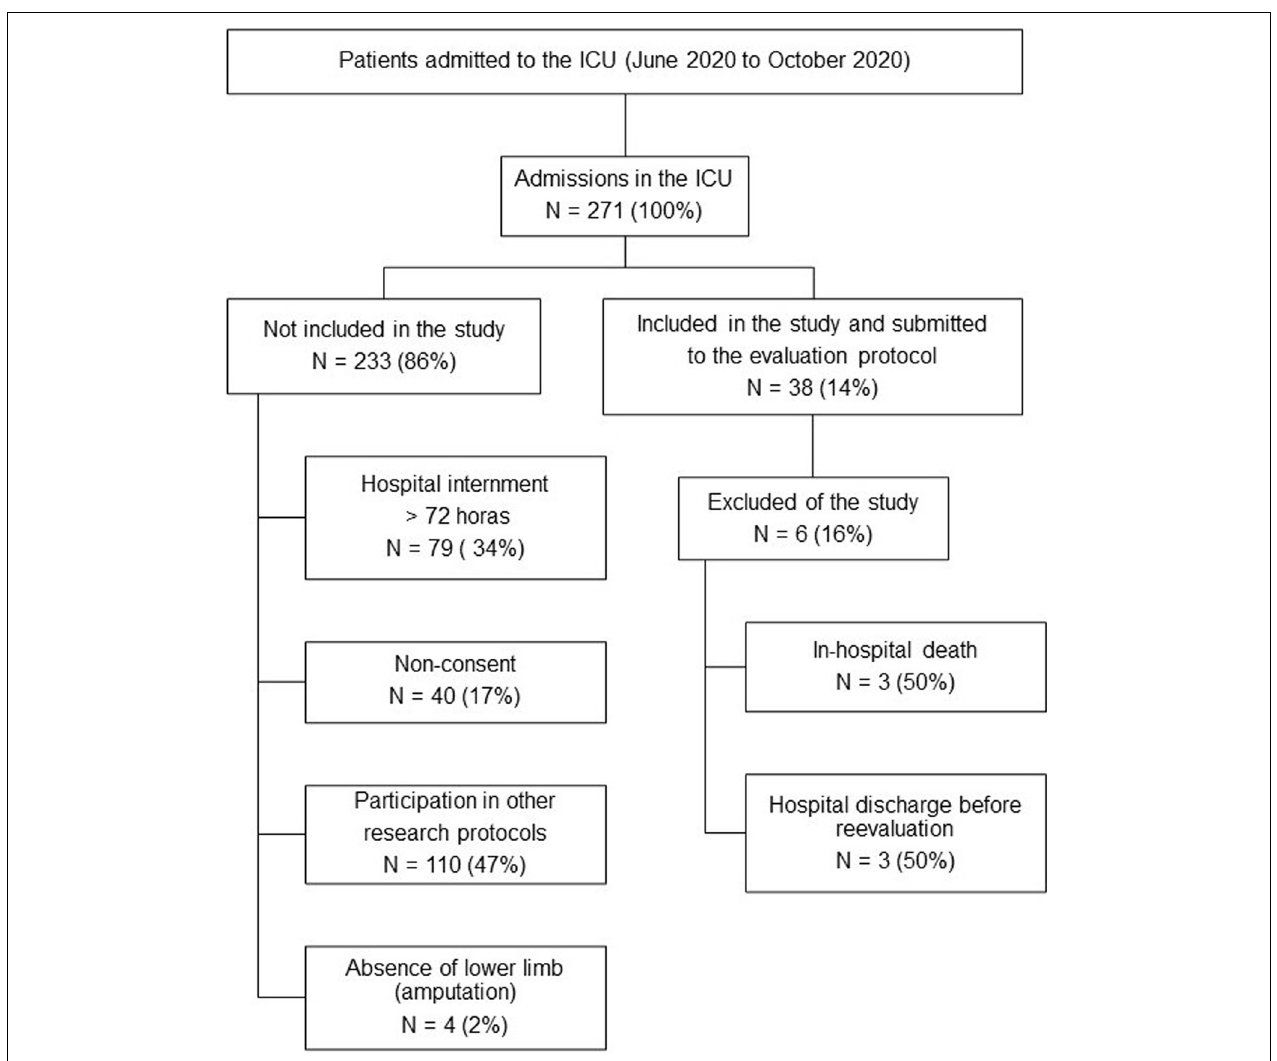
FIGURE 1 | Diagram of the study. ICU, intensive care